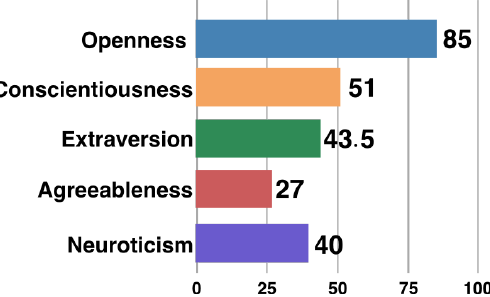
Figure 3. Graphical depiction of a sample Big Five test